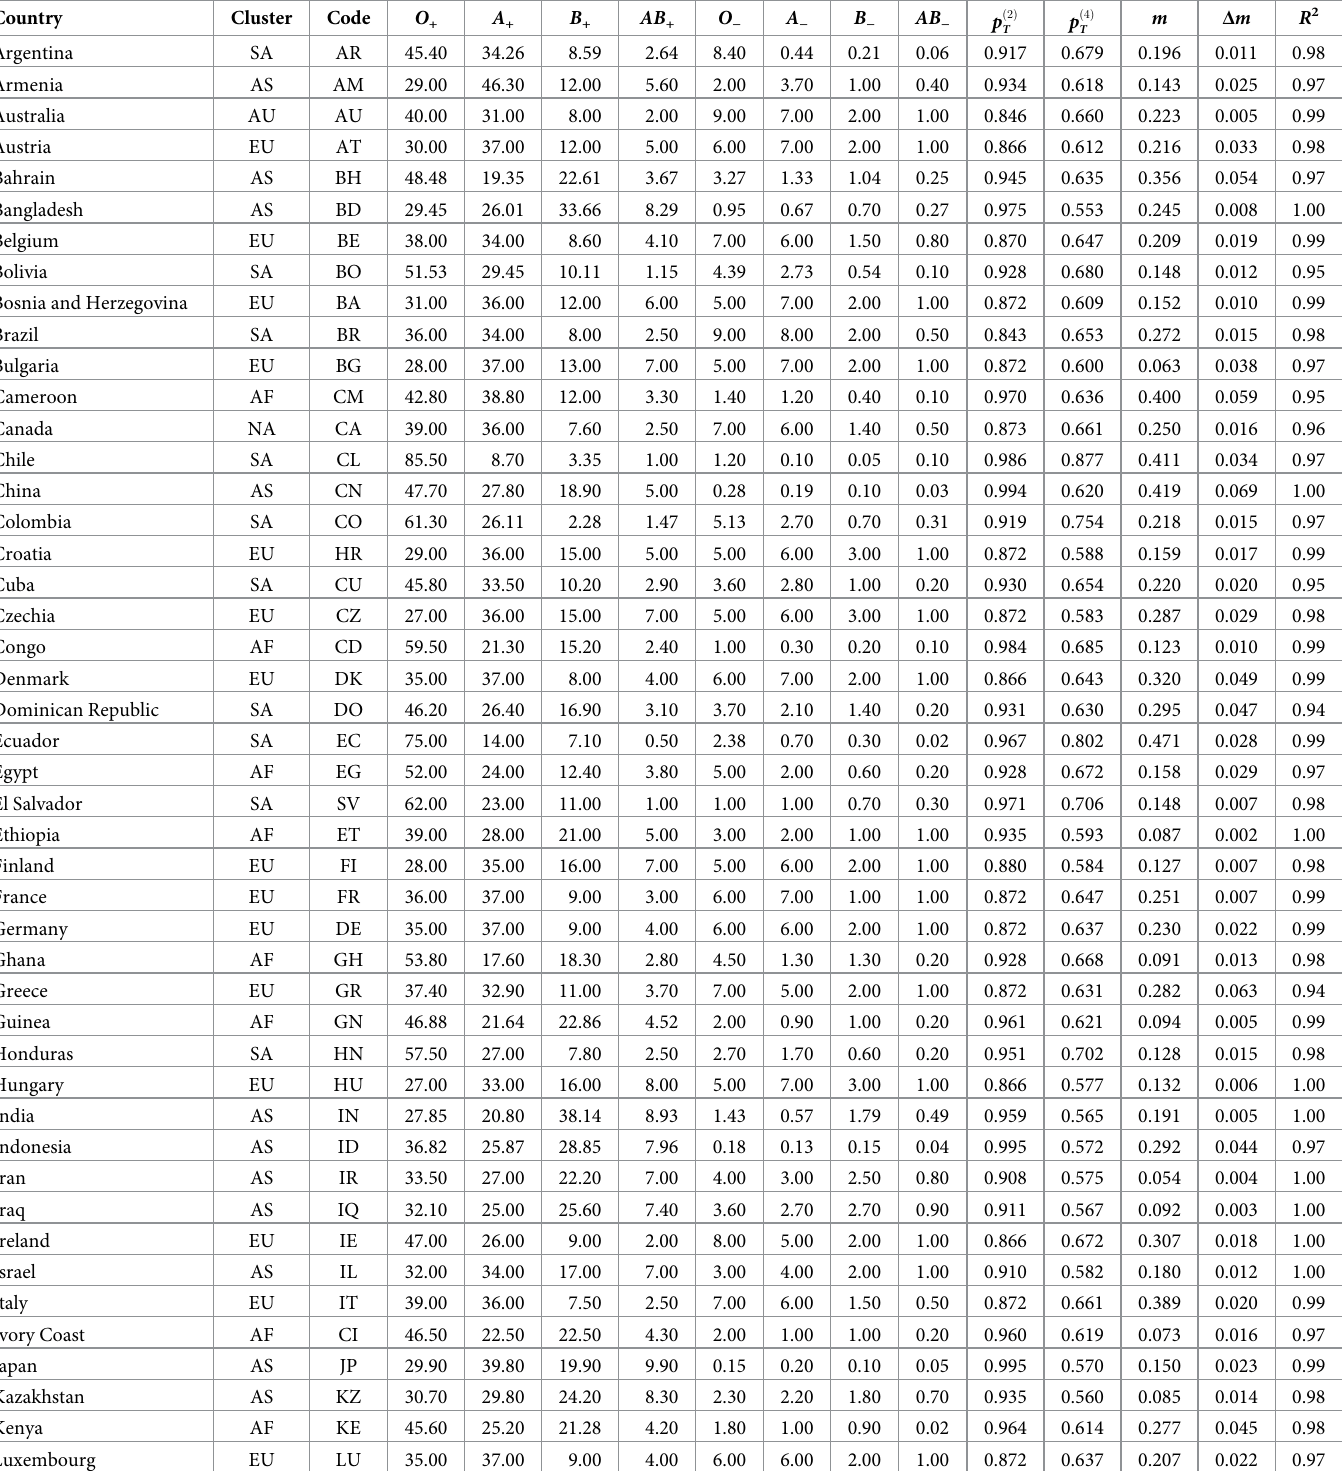
), susceptibility, p ð k Þ , and inverse characteristic time, m , of the exponential phase of the infection for the analyzed countries i T